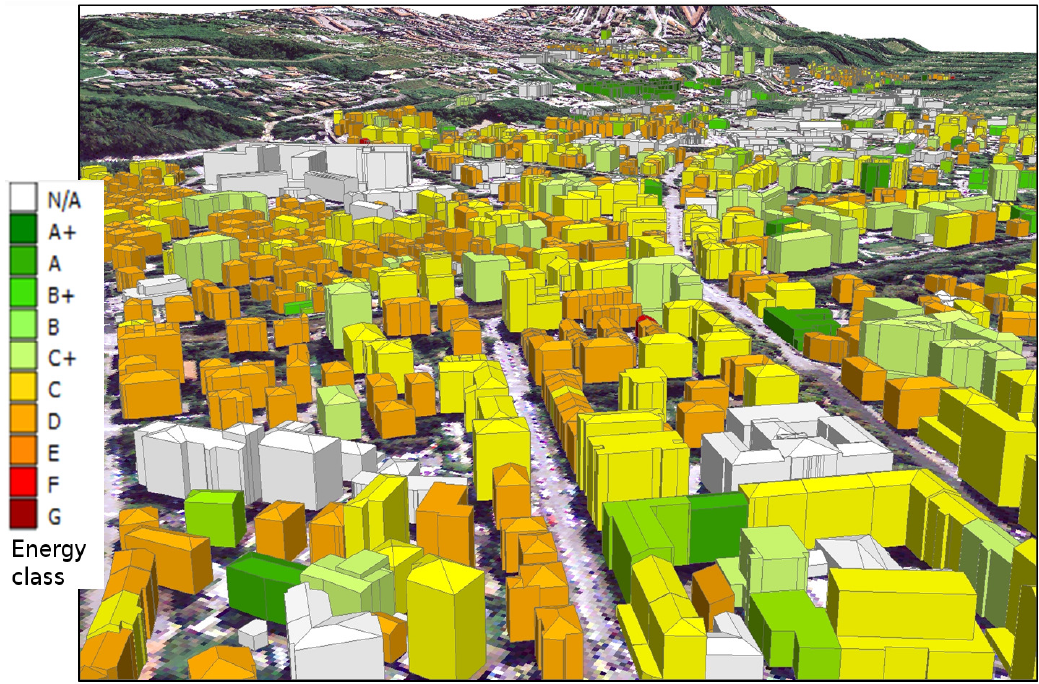
Figure 10 Example of an application developed starting from the semantic 3D city model of the study area in Trento: estimation of energy demand for heating for each residential